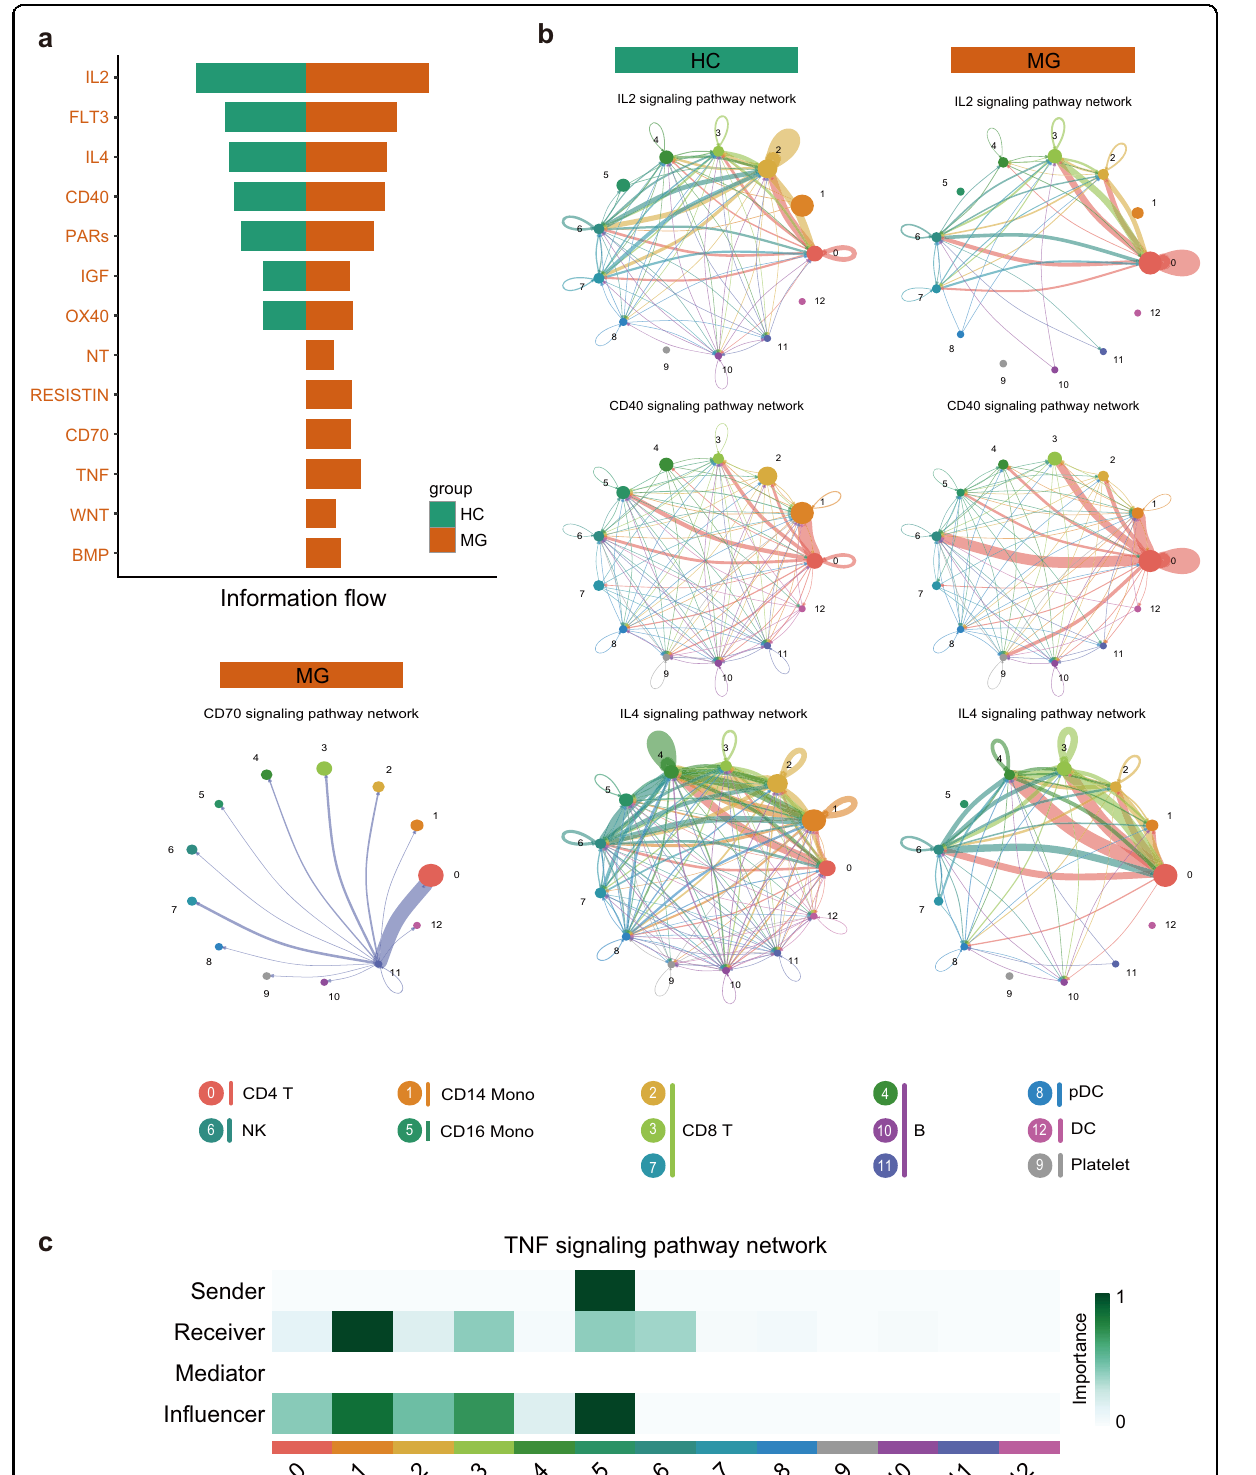
Fig. 6 Evaluation of expression of genes for receptors and ligands, and cell-cell communication. a The signi fi cant signaling pathways were ranked based on their differences in overall information fl ow within the inferred networks between HCs and myasthenia gravis patients. We show the more enriched signaling pathways colored in orange in myasthenia gravis. b Circos plot showing the inferred intercellular communication network across major cell types using the color of b for HCs and MG patients. c Heatmap showing the relative importance of each cell group based on the computed four network centrality measures of the TNF signaling pathway. Information fl ow refers to the overall communication